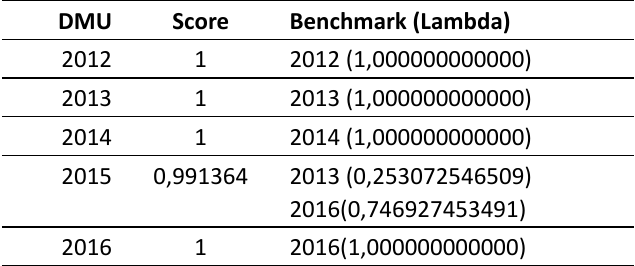
Table 4: Results of Efficiency Analysis Using DEA with (Output Oriented) DMU Score Benchmark (Lambda)